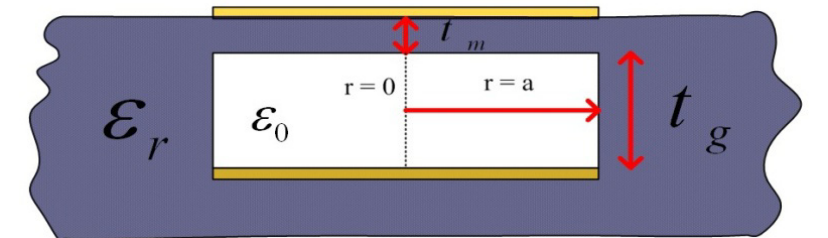
Figure 2. Cross-section of variable capacitance